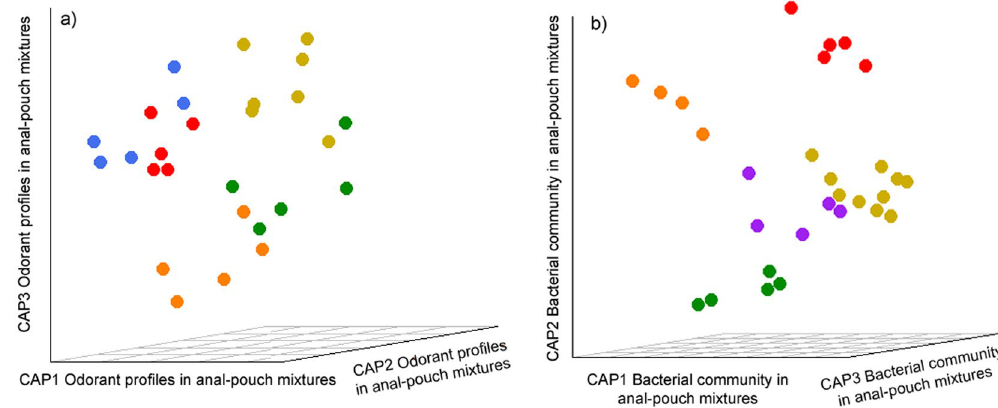
Figure 3. Partial distance-based redundancy analysis plots (capscale function in R) showing separation between meerkats by their group membership (plots are restricted to groups from which at least four members were sampled and for which sex and social class were partialled-out to better illustrate the separation). ( a ) Partial dbRDA based on Jaccard distance in chemical composition in anal-pouch mixtures and ( b ) partial db- RDA based on Bray-Curtis distances in bacterial communities in anal-pouch mixtures. Each colour represents a different social group.